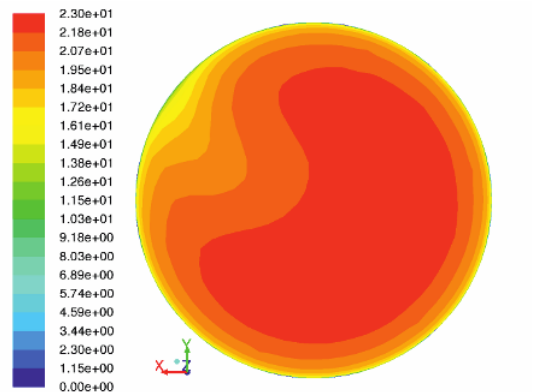
Figure 17: Instantaneous velocity distribution in metering run #1